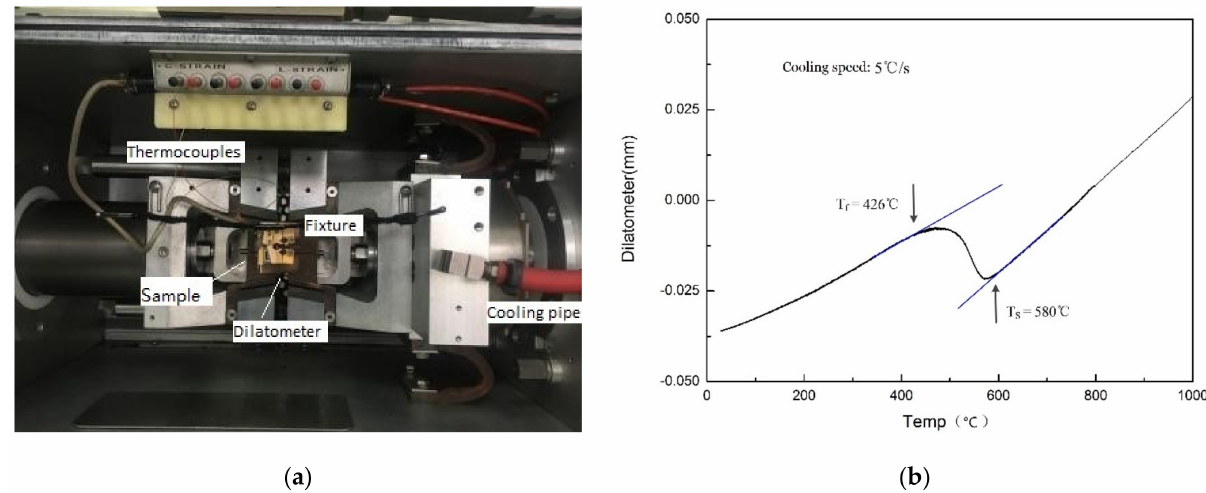
Figure 5. Welding thermal simulation: ( a ) the Gleeble 3500 thermal simulator; ( b ) a typical expansion curve (cooling rate = 5 ◦ C/s).